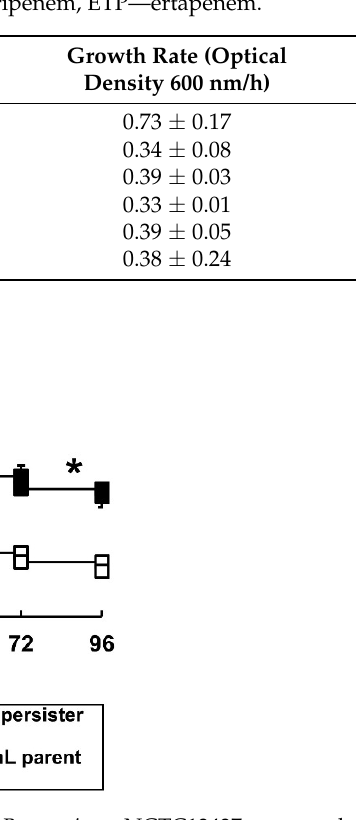
Table 3. Growth rates of the P. aeruginosa NCTC13347 parent strain, and cultures of 5 random persister colonies. Persisters were isolated after 96 h post-infection from infected G. mellonella larvae treated with a single dose of the triple combination of MEM + DOR + ETP. Bacterial growth was measured in MHB at 37 °C with shaking and was performed in duplicate and ± represents the SEM.